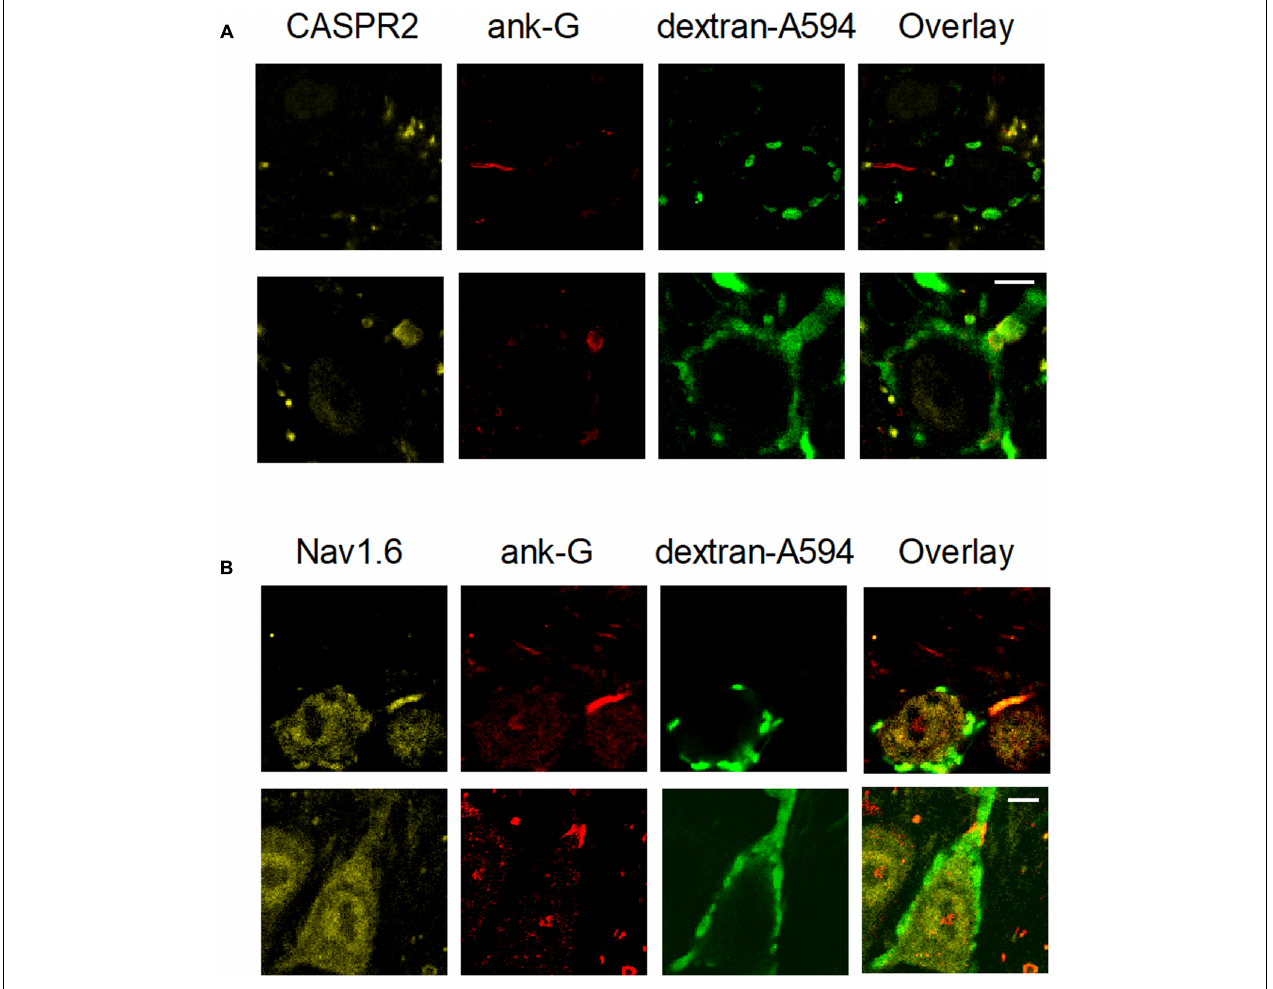
FIGURE 10 | Structural differences between heminodes and axon initial segments (AIS) in the MNTB. Calyces were filled with dextran-A594 via midline electroporation. (A) A filled calyx stained with anti-CASPR2 and anti-ankyrin-G antibody, as well as an overlay of these images. (B) A filled calyx with staining of anti-Nav1.6 and anti-ankyrin-G antibody, as well as an overlay of these images. Calibration bars 5 µ